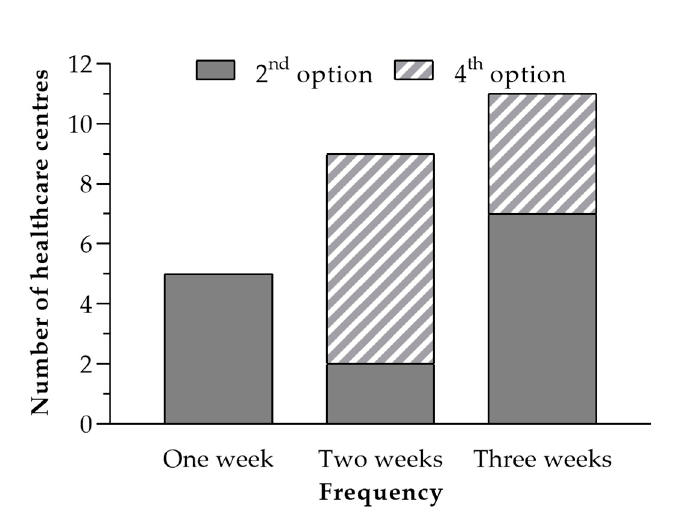
Figure 5. Bar graph of maintenance periodicity.